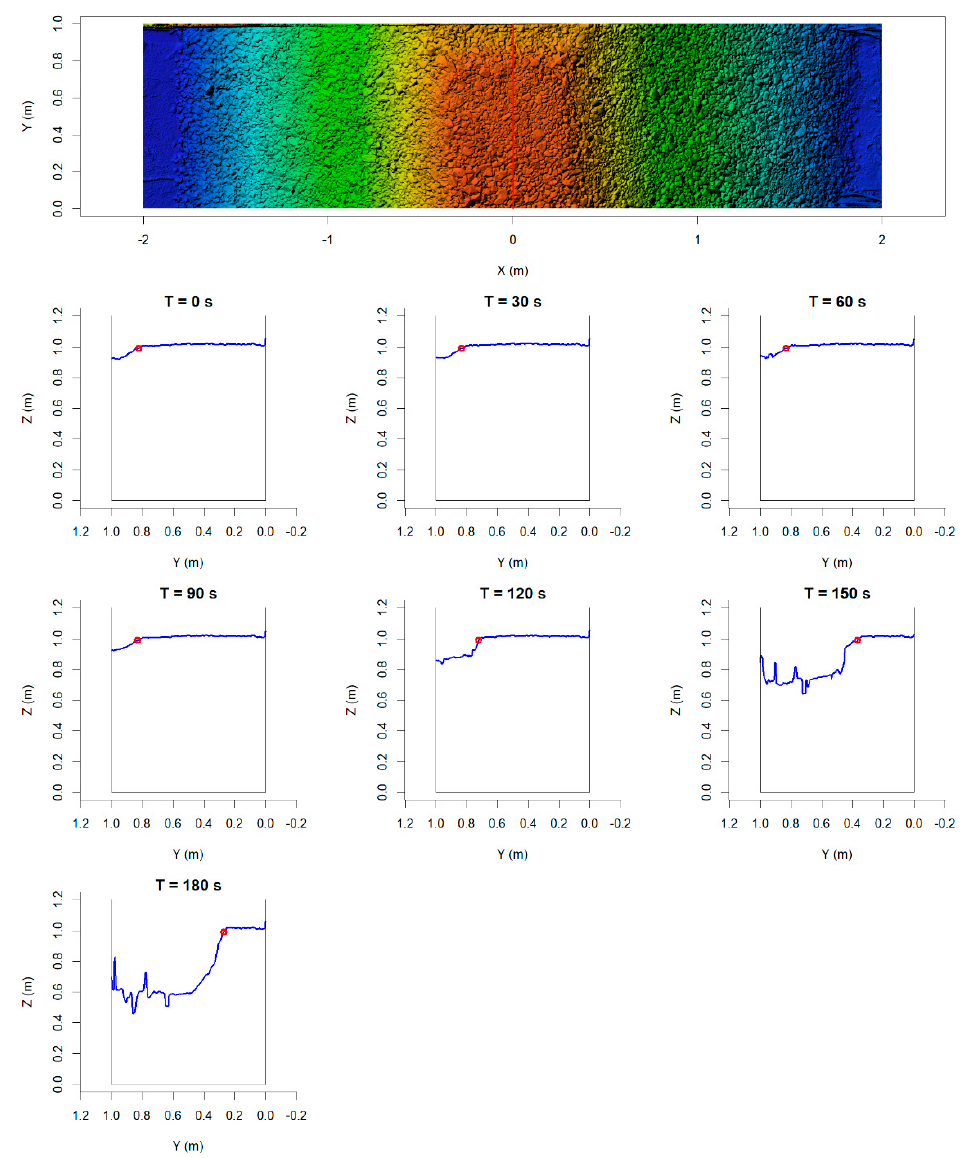
Figure A8. Cross-section profiles for X = 0 m (centre line) extracted from H3 dynamic 3D model; T = 0 s is immediately before initial observed erosion at downstream edge of crest; red circle indicates breach edge as used in further analyses.